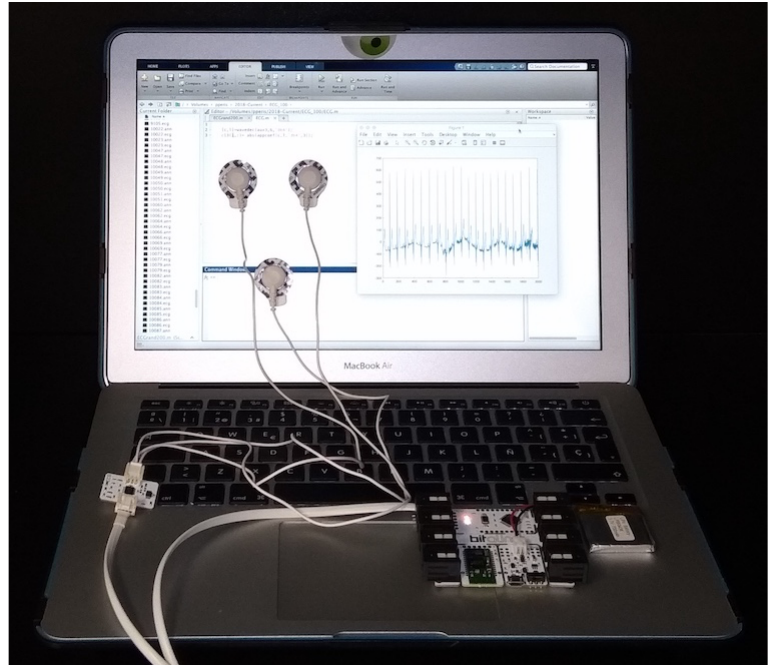
Figure 2. Hardware for building an ECG-based RNG.